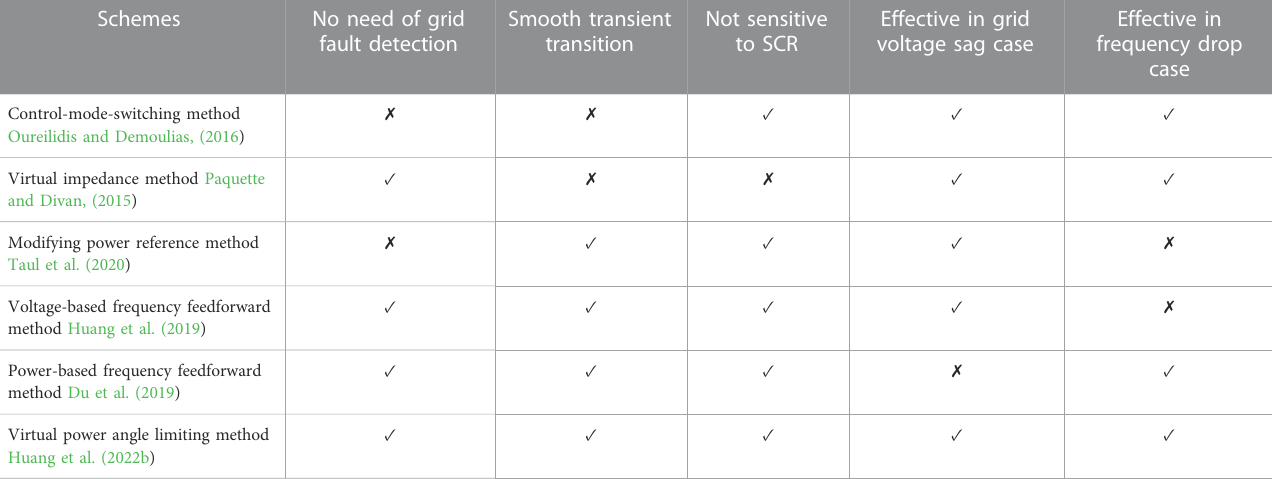
TABLE 3 Comparison of different overcurrent protection schemes of GFM converters (Huang et al., 2022b).